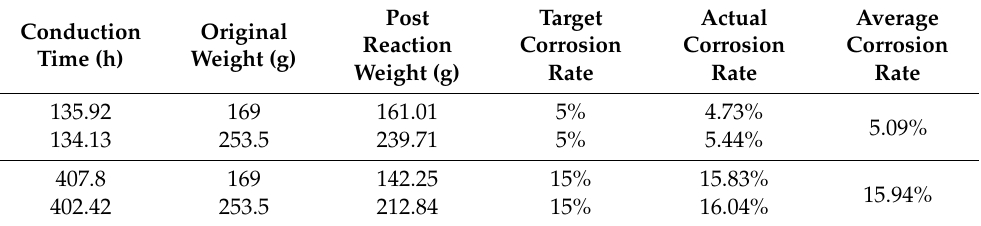
Table 2. The measured corrosion rate of steel bar.